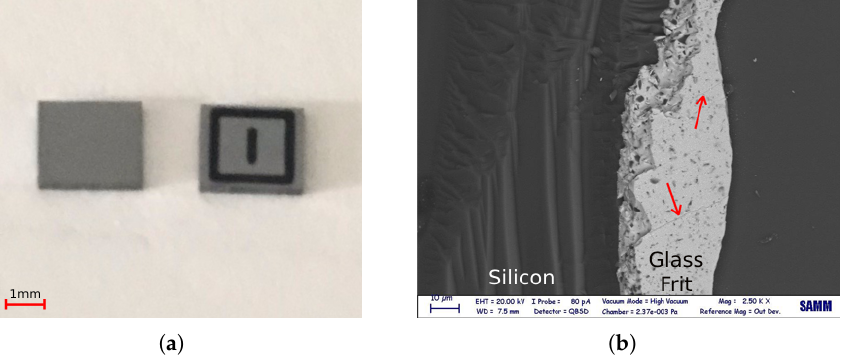
Figure 10. Optical observations after shear test, category A: ( a ) Si die parts after debonding; ( b ) cracks on gf